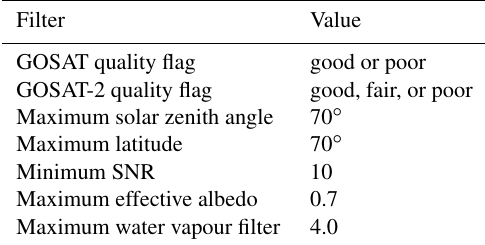
Table 2. Pre-processing filter limits.